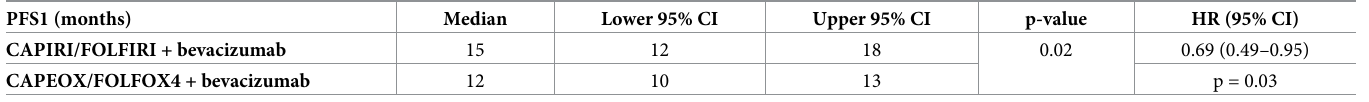
Table 2. Progression-free survival in the first-line setting according to the backbone chemotherapy regimen. PFS1 (months)